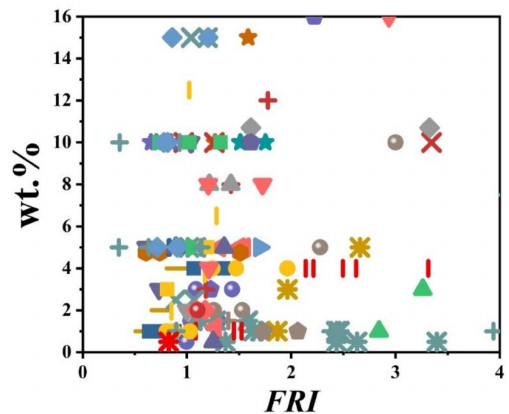
Figure 7. FRI values as a function of the mineral FR type and content from close-up and long-shot views. Symbols are indicative of di ff erent types of mineral flame retardant used. The diversity and abundance of data were reasons why such di ff erent scales were provided for detection of behavior of PP against flame. Here: (cid:4) ATH-50